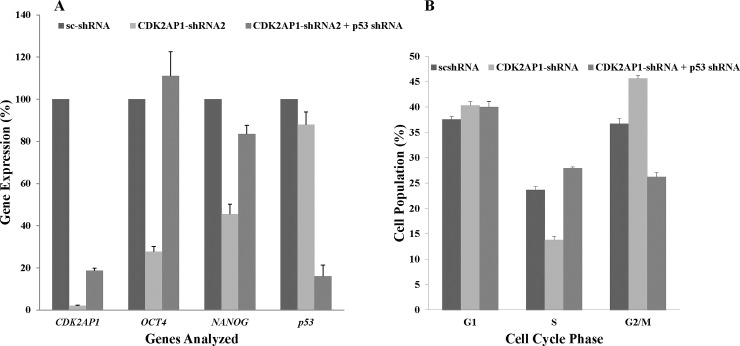
Simultaneous knockdown of CDK2AP1 and p53 prevents the reduction in OCT4 and NANOG levels and the accumulation in the G2/M phase of the cell cycle.A. BG01v hESCs were transduced with scrambled shRNA (sc-shRNA), CDK2AP1 shRNA or co-transduced with CDK2AP1 and p53 shRNAs. The gene expression of CDK2AP1, OCT4, NANOG and p53 was analyzed in those cells by qPCR. We found that down regulating p53 with CDK2AP1 prevented the CDK2AP1-knockdown induced reduction in OCT4 and NANOG levels (p < 0.05). Results are presented together with standard deviation from experiments conducted in triplicate. B. When p53 is simultaneously downregulated with CDK2AP1, there was no reduction in cells in the S phase and no increase in cells in the G2/M phase of the cell cycle. Around 6% of the analyzed cells were in the sub G0/G1 phase of the cell cycle. Results are presented together with standard deviation from experiments conducted in triplicate. Cell cycle data of scshRNA and CDK2AP1-shRNA transduced hESCs from Fig 3B were included in this figure to facilitate comparison.